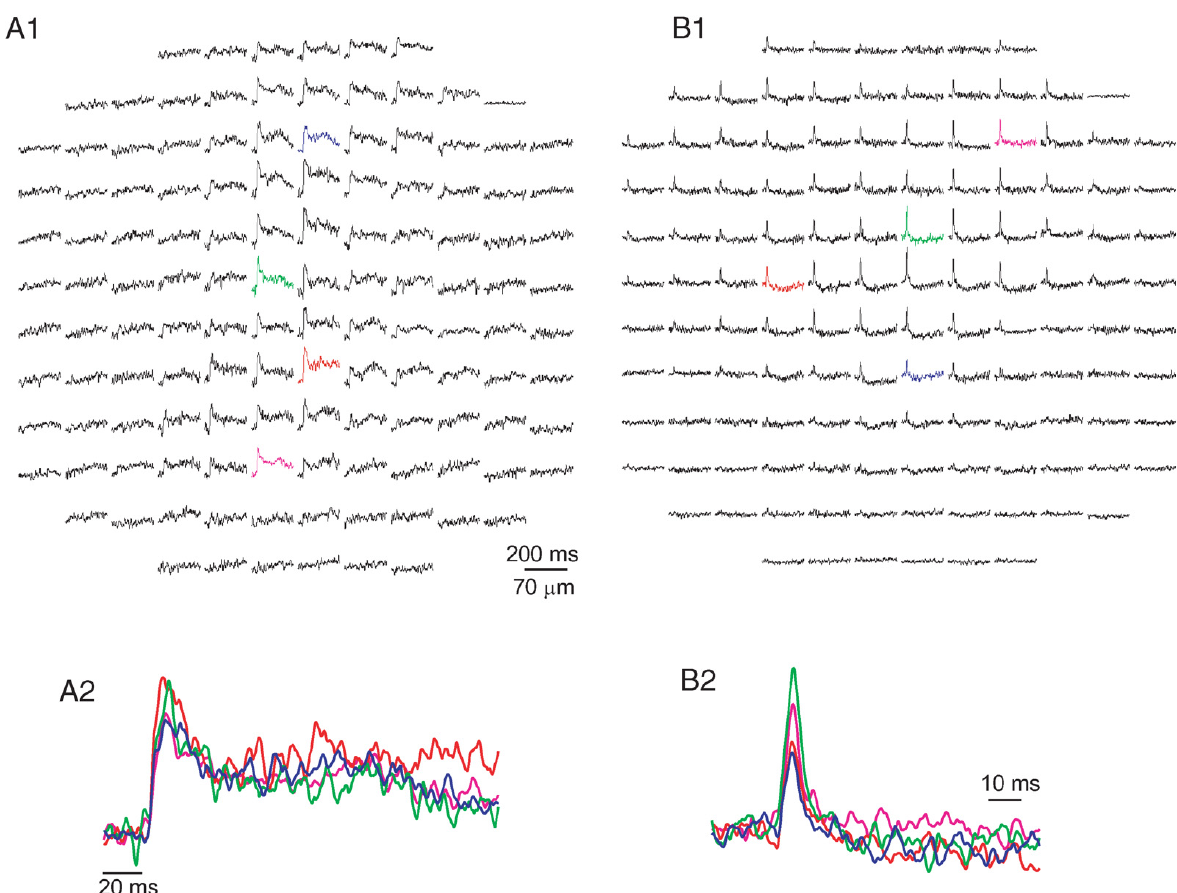
Figure 1. The two classes of responses to white matter stimulation. Responses are displayed as a change in fluorescence as a function of time in 128 sites in the cerebellar cortex. Each diode collects light from an area of 70 (cid:2) 70 m m with a 20 (cid:2) objective (NA 0.5). All presentations are arranged such that the medio- lateral axis is from right to left. And all presentations show the average of three stimulus repetitions. ( A ) A response organized in a parasagittal band of excitation, with half duration of 29ms. The colored diodes from A1 are shown in an enlarged scale in A2. Note the prolonged second positive wave that followed the initial fast response. ( B ) A radial patch of activity that is composed of a brief excitatory component (5ms at half amplitude) followed by a prolonged inhibitory component. The colored diodes in B1 are shown in an enlarged scale in B2. Responses of the type shown in A were attributed to CF activation, and responses of the type shown in B to MF